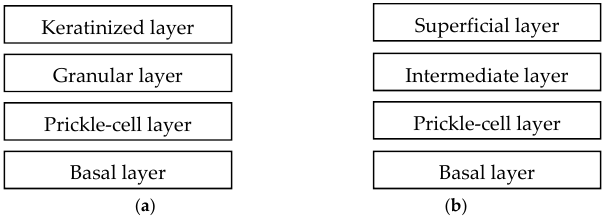
Figure 2. Structures of ( a ) keratinized and ( b ) non-keratinized oral mucosa [10].